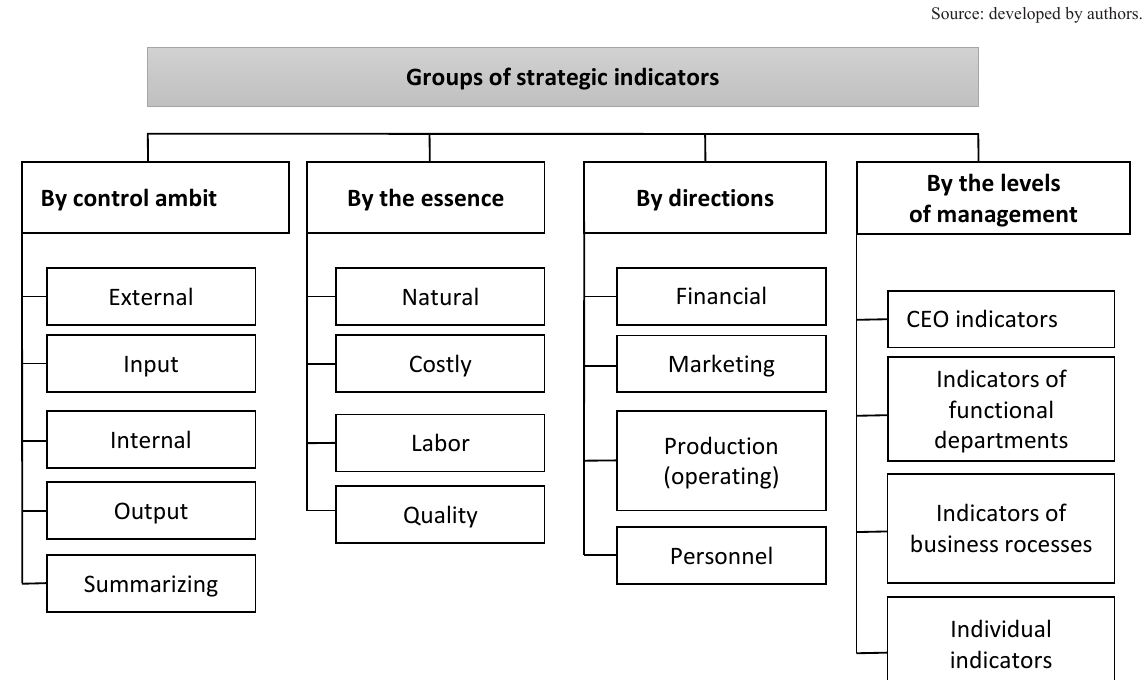
Source: developed by